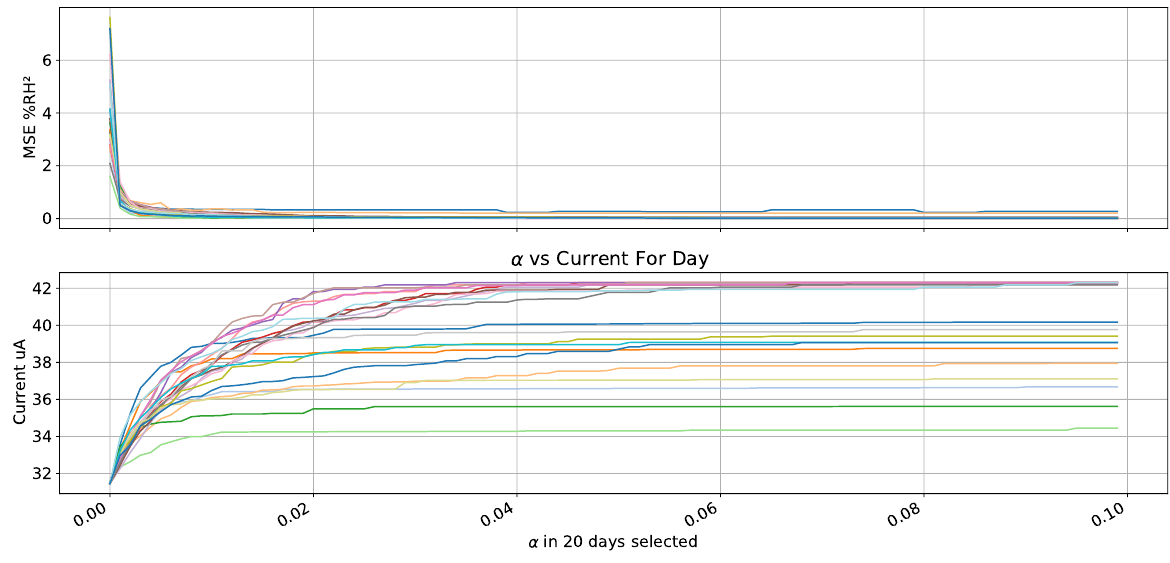
Figure 18. α analysis vs. Mean Squared Error and